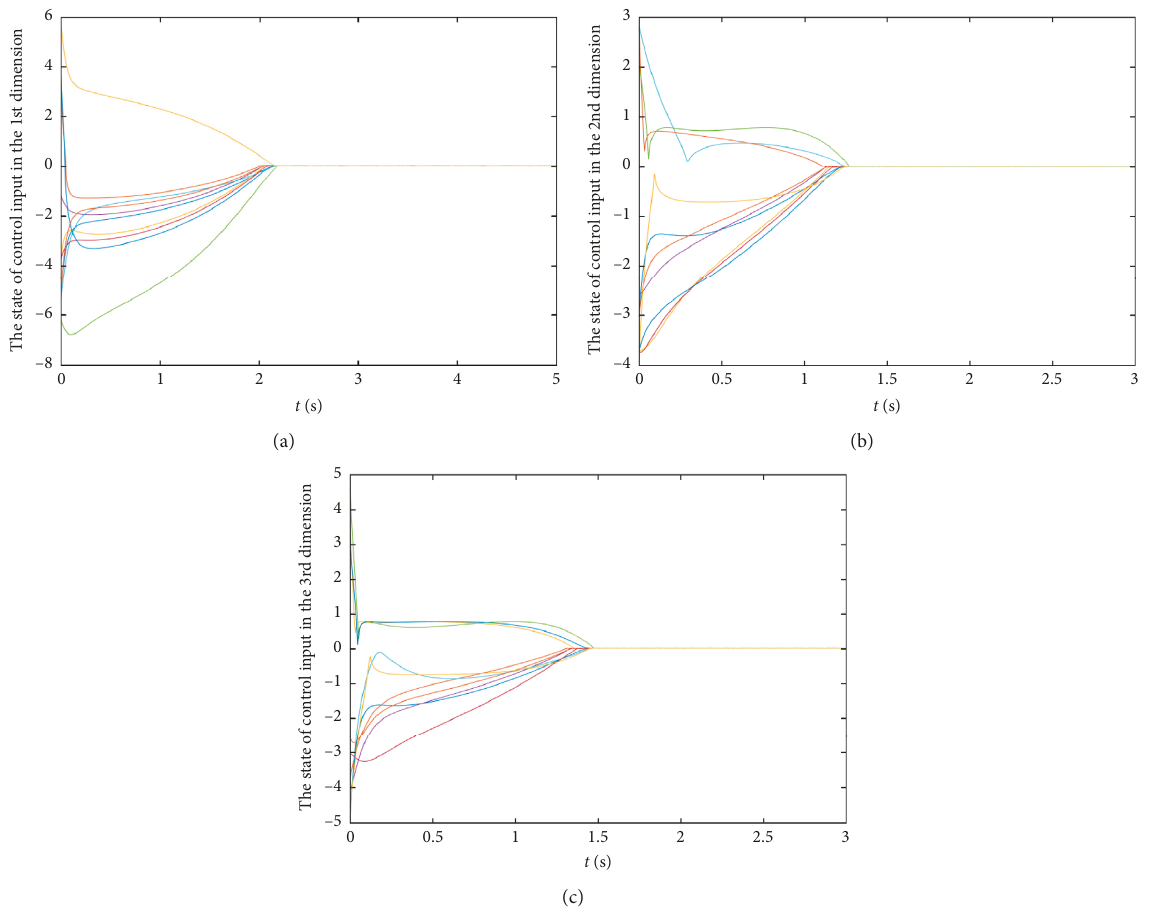
i in different dimensions.